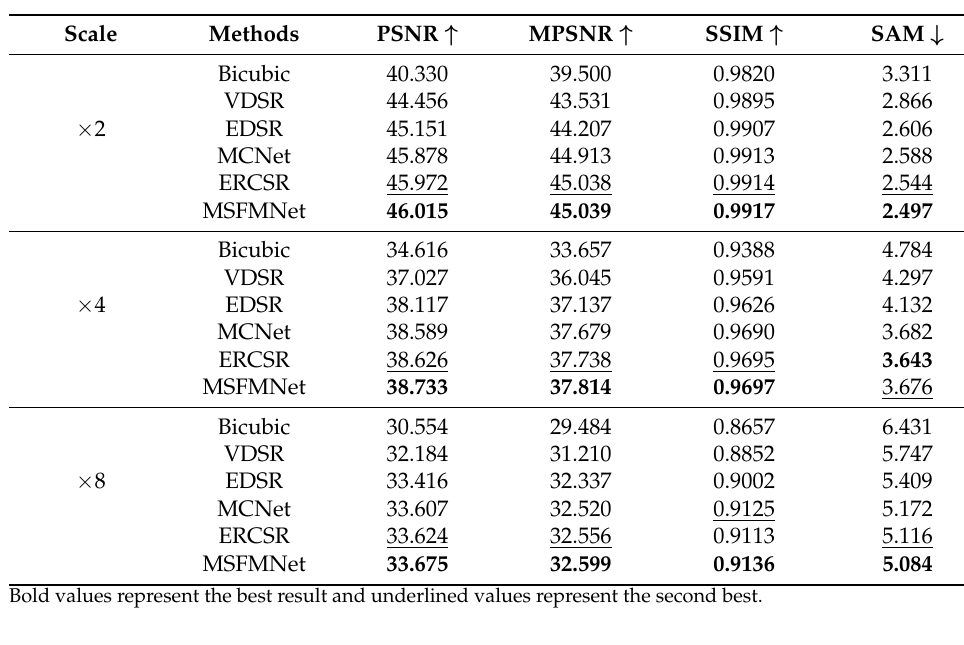
Table 1. Quantitative evaluation on the cave dataset of state-of-the-art hyperspectral image sr algorithms: average psnr/mpsnr/ssim/sam for scale factors 2, 4, and 8. Scale Methods